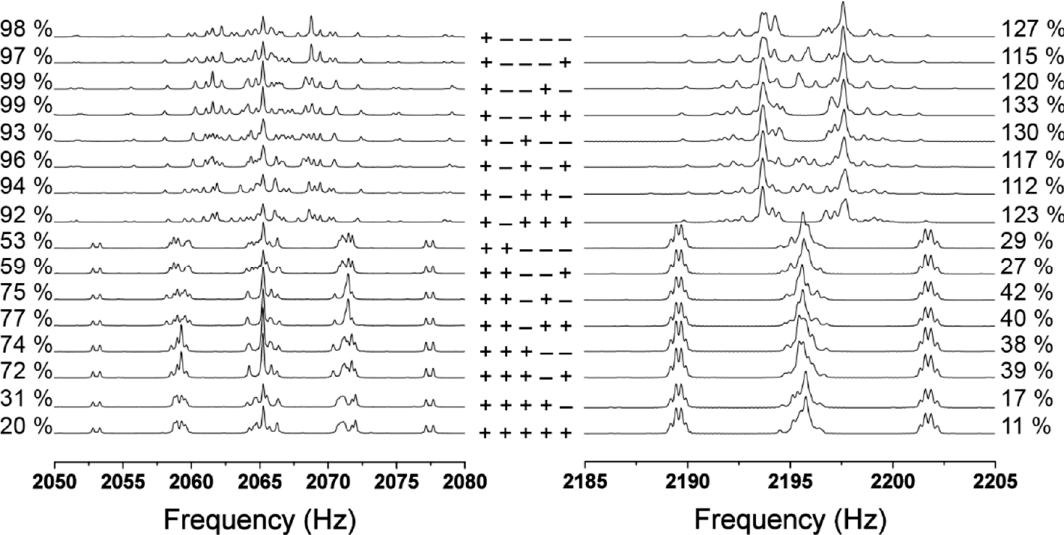
Figure 11. The 16 different possible sign permutations of the 5 J -couplings measured for the JCS of 1,4-difluorobenzene. The absolute signs are denoted between the 19 F ( left ) and 1 H spectra ( right ). The same spectra were obtained when there were degenerative, same relative sign combinations (e.g., + + + + + is equivalent to − − − − − ). The signs from left to right correspond to absolute signs of 3 J HF , 4 J HF , 5 J FF , 3 J HH , and 4 J HH , respectively.